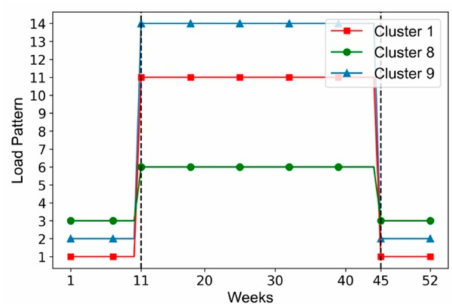
Figure 18. The influence of summer time from 11st week to 45th week.